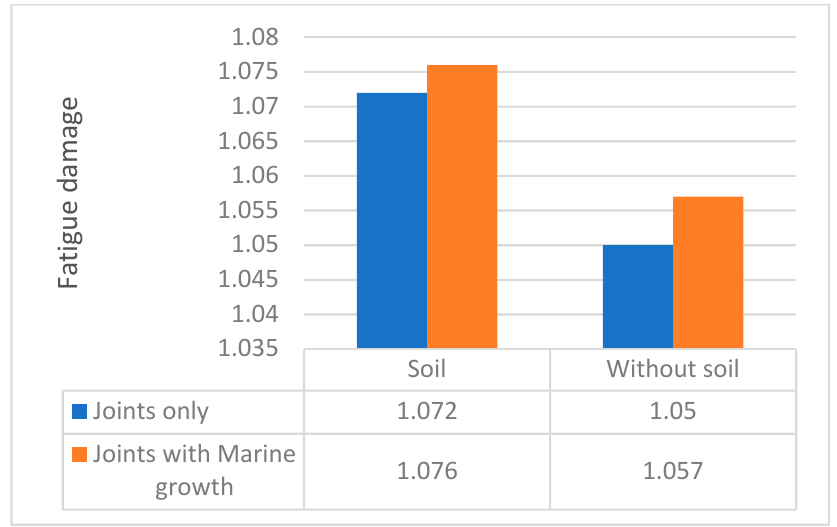
Figure 14. Fatigue damage showing the effect of soil and marine growth.